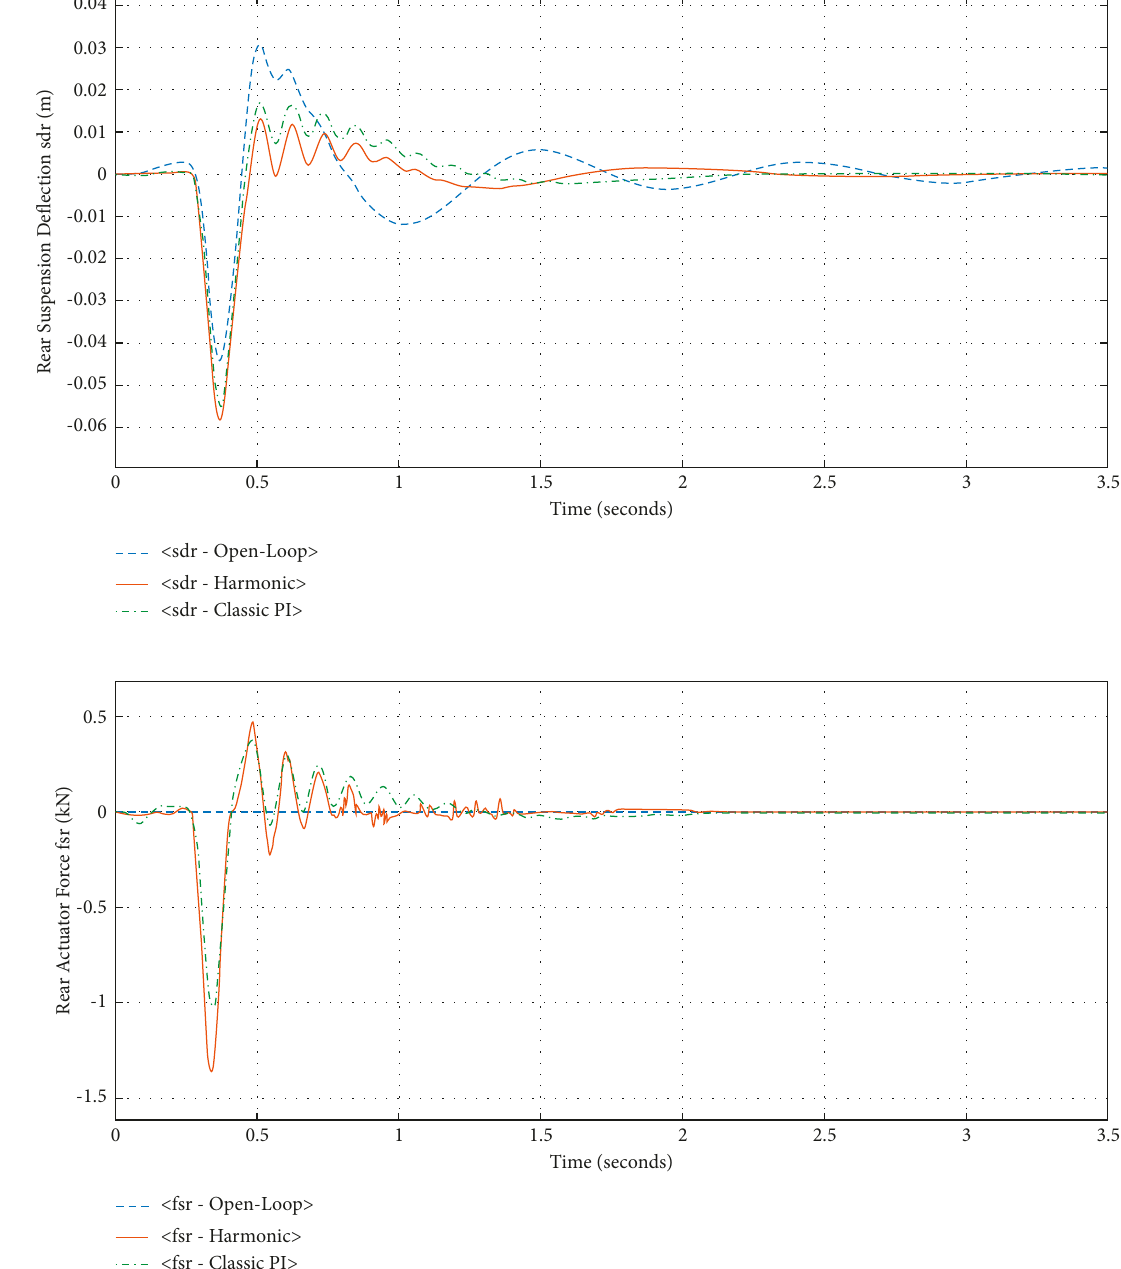
f dr and rear actuator force sr results: blue dash line means open-loop, red continuous line means